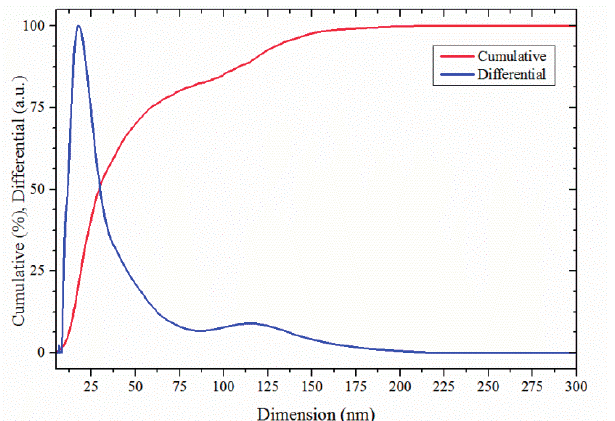
Figure 3. Particle size distribution (PSD) of the pure CeO 2 sample after drying and re-dispersion in water, measured with an X-ray disc centrifuge. The blue line is the differential volumetric distribution and the red line is the cumulative volumetric